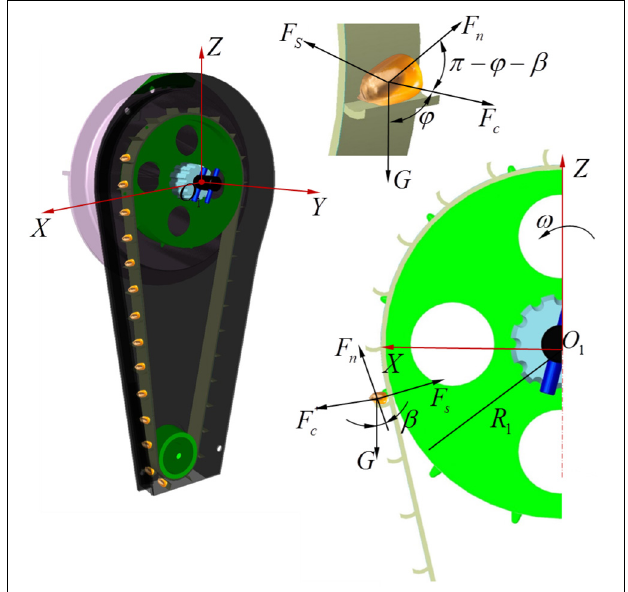
FIGURE 3 | Force analysis diagram of the stable transport and delivery process.